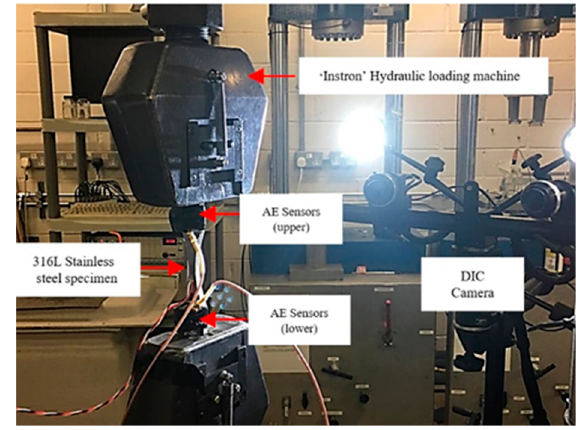
Figure 11. Experimental setup for the fatigue test.